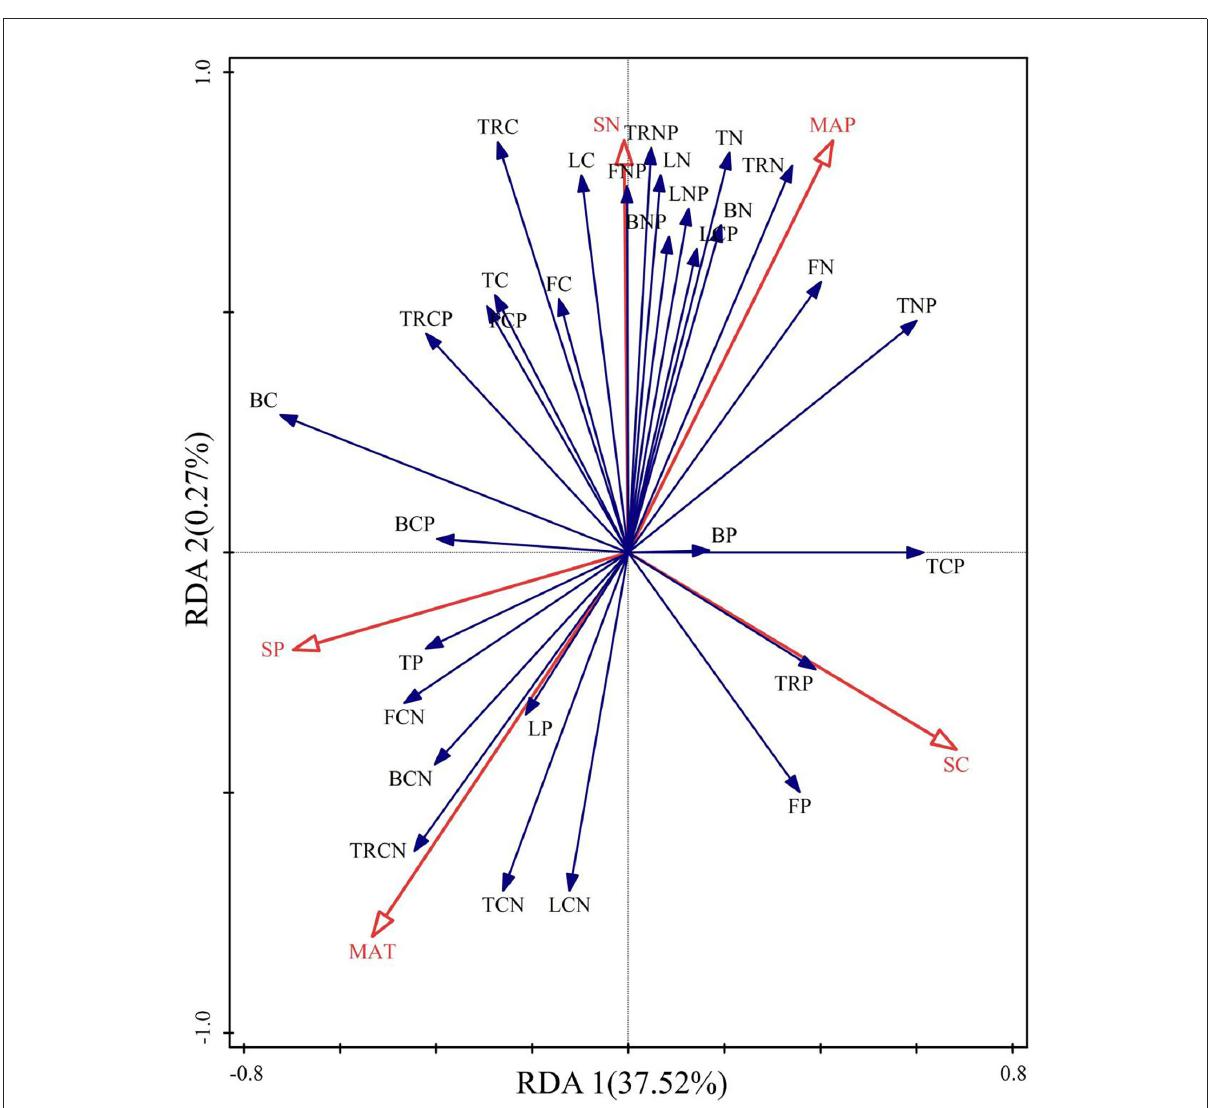
FIGURE5 Redundancy analysis (RDA) of the relationships between the stoichiometry of Qinghai spruce and environmental factors. Red arrows represent environmental factors; tissue types are L, leaves; B, branches; T, trunk; TR, thick roots; F, fine roots. S denotes soil, MAT is mean annual temperature, and MAP is mean annual precipitation. CN represents C:N, CP denotes C:P, and NP represents